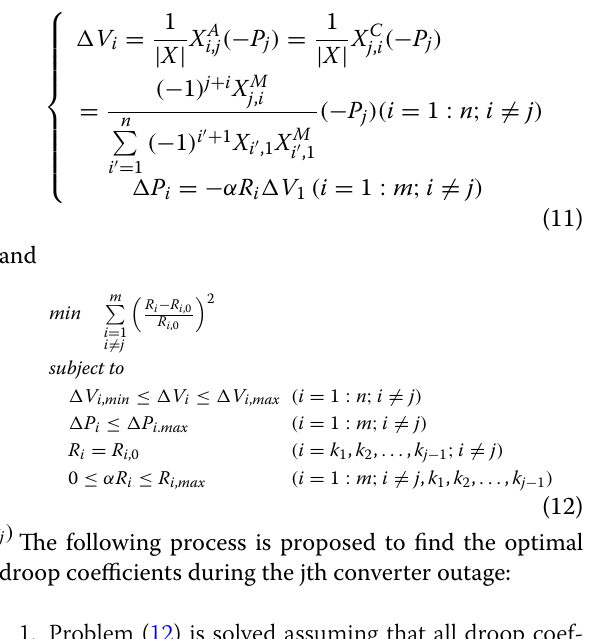
where P j refers to the active power of the jth converter before its outage. The DC voltage and active power deviations of VSC stations according to (10) and the constrained optimization problem are respectively deter- mined